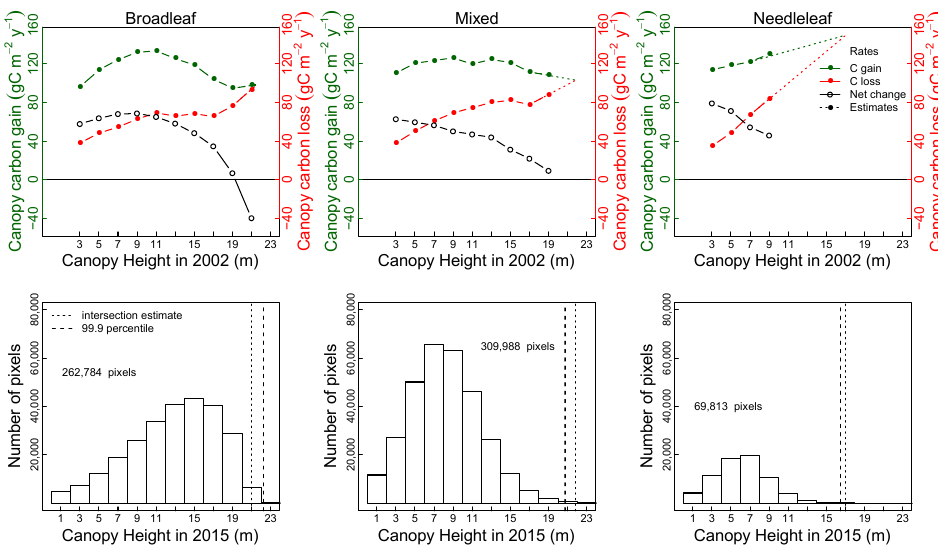
Figure 3. Relationship between canopy height in 2002 and net change in canopy carbon and its deconvolution as carbon gain through aboveground tree NPP and carbon loss through debris-fall. Bullets give mean values of distributions binned by 2 m canopy height class. Lower panels show distributions of 2015 canopy heights by vegetation type. Dotted lines in top and bottom panels indicate equilibrium heights as local linearized estimates of carbon gain equals carbon loss with net carbon change equal zero, at canopy height equilibrium. Vertical dashed lines in lower panels indicate 99.9 percentile for 2015 canopy heights by vegetation type. Net change in top panels has units of carbon gain and carbon loss. For all three forest types, the expected equilibrium height based on difference between latent variables G and D deconvolved using the generalized method of moments was similar to the maximum canopy heights